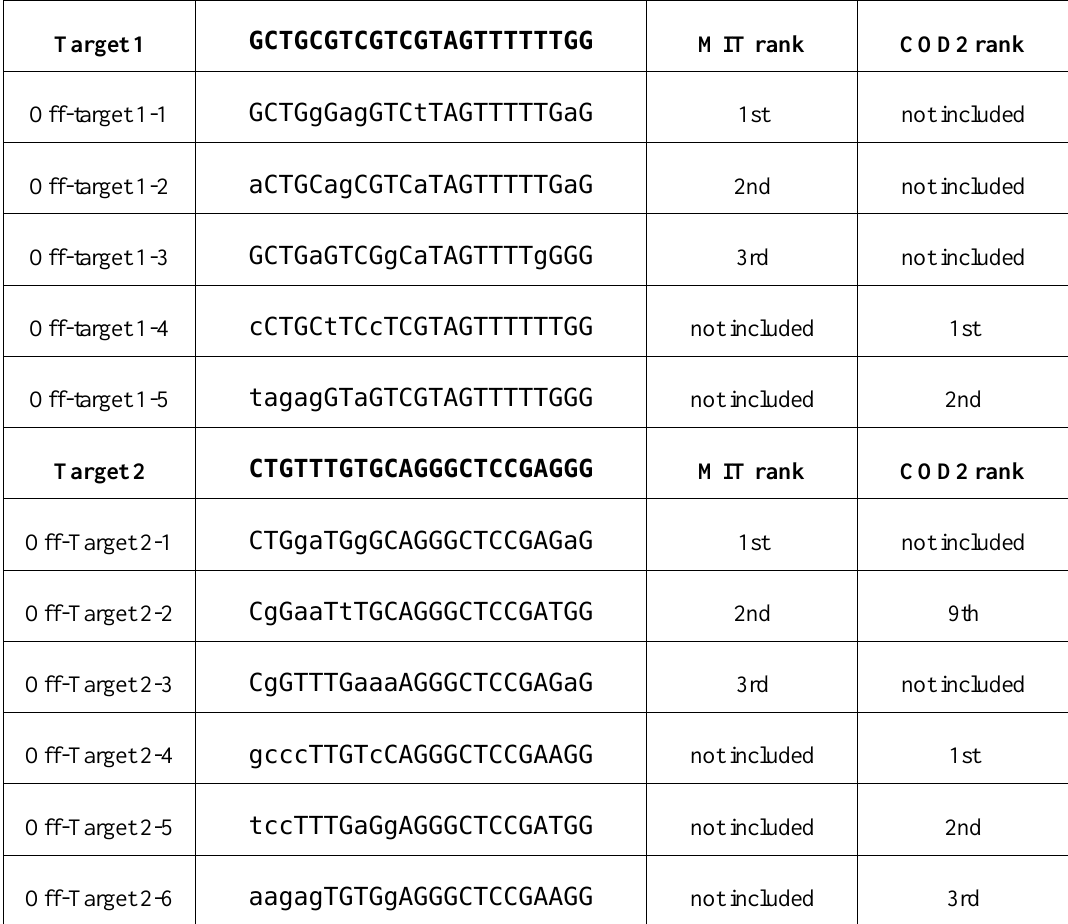
Note: Lower-cased letters in sequences mark mismatches between an off-target and its corresponding target. More details are in “Compare3MostlikelyOffTargets.xls” of additional file 5. COD2 only